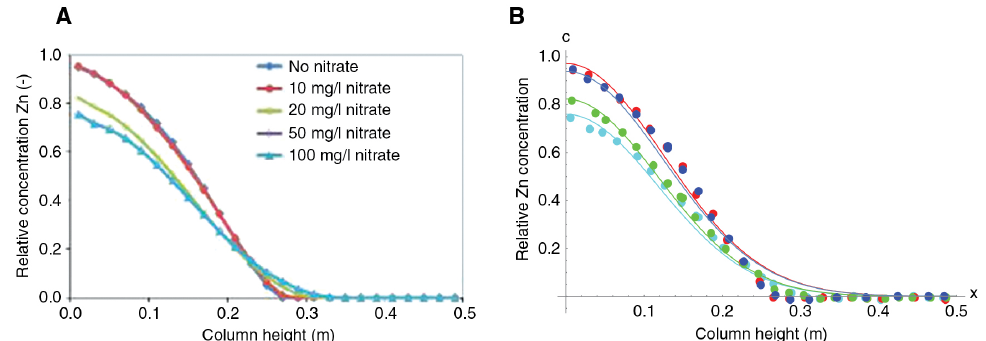
Figure 4: (A) Zn removal profile after 100 days in case of nitrate intrusion. (B) Comparison between theoretical predic- tions and simulation results [22].